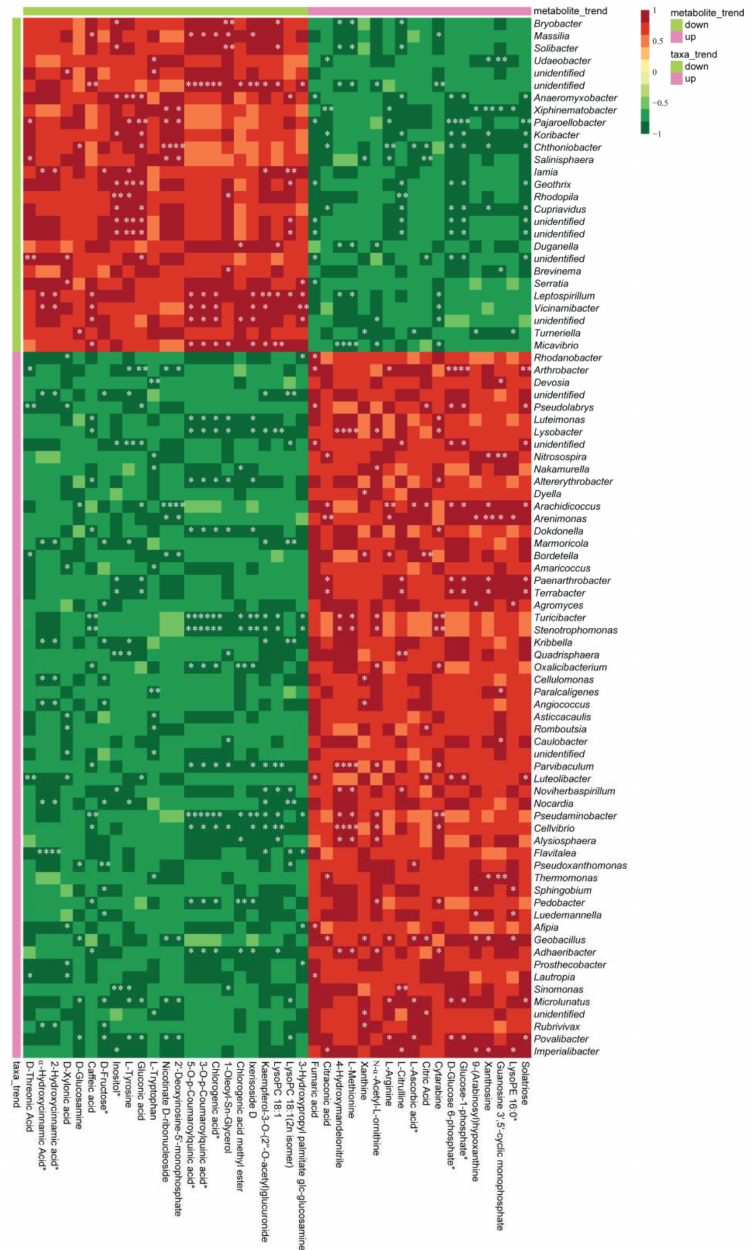
Figure 8. Heatmap based on Spearman’s correlation index values between differential microbial taxa and metabolites responding to bioorganic fertilizer and no fertilizer treatments in the rhizosphere. Correlation were considered significant when the p -value < 0.05 (* p < 0.05, ** p <